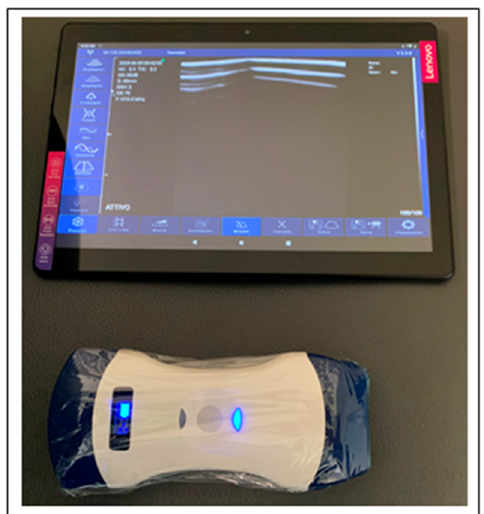
Figure 2. Wireless ultrasound equipment to avoid contamination. A wireless ultrasound probe with respectively a 4.5 mHz convex probe on the right side, and a 7.5 mHz linear probe on the left one. The transducer, wrapped with a single use plastic cover to avoid contamination, is wi-fi connected with the tablet which in turn, is encircled by a plastic film.